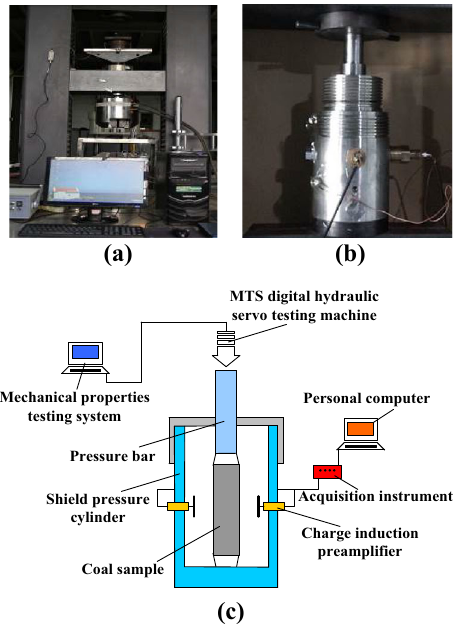
Fig. 3 Mechanical properties testing system. a MTS digital hydraulic servo testing machine, b Shield pressure cylinder, c Schematic diagram of test system